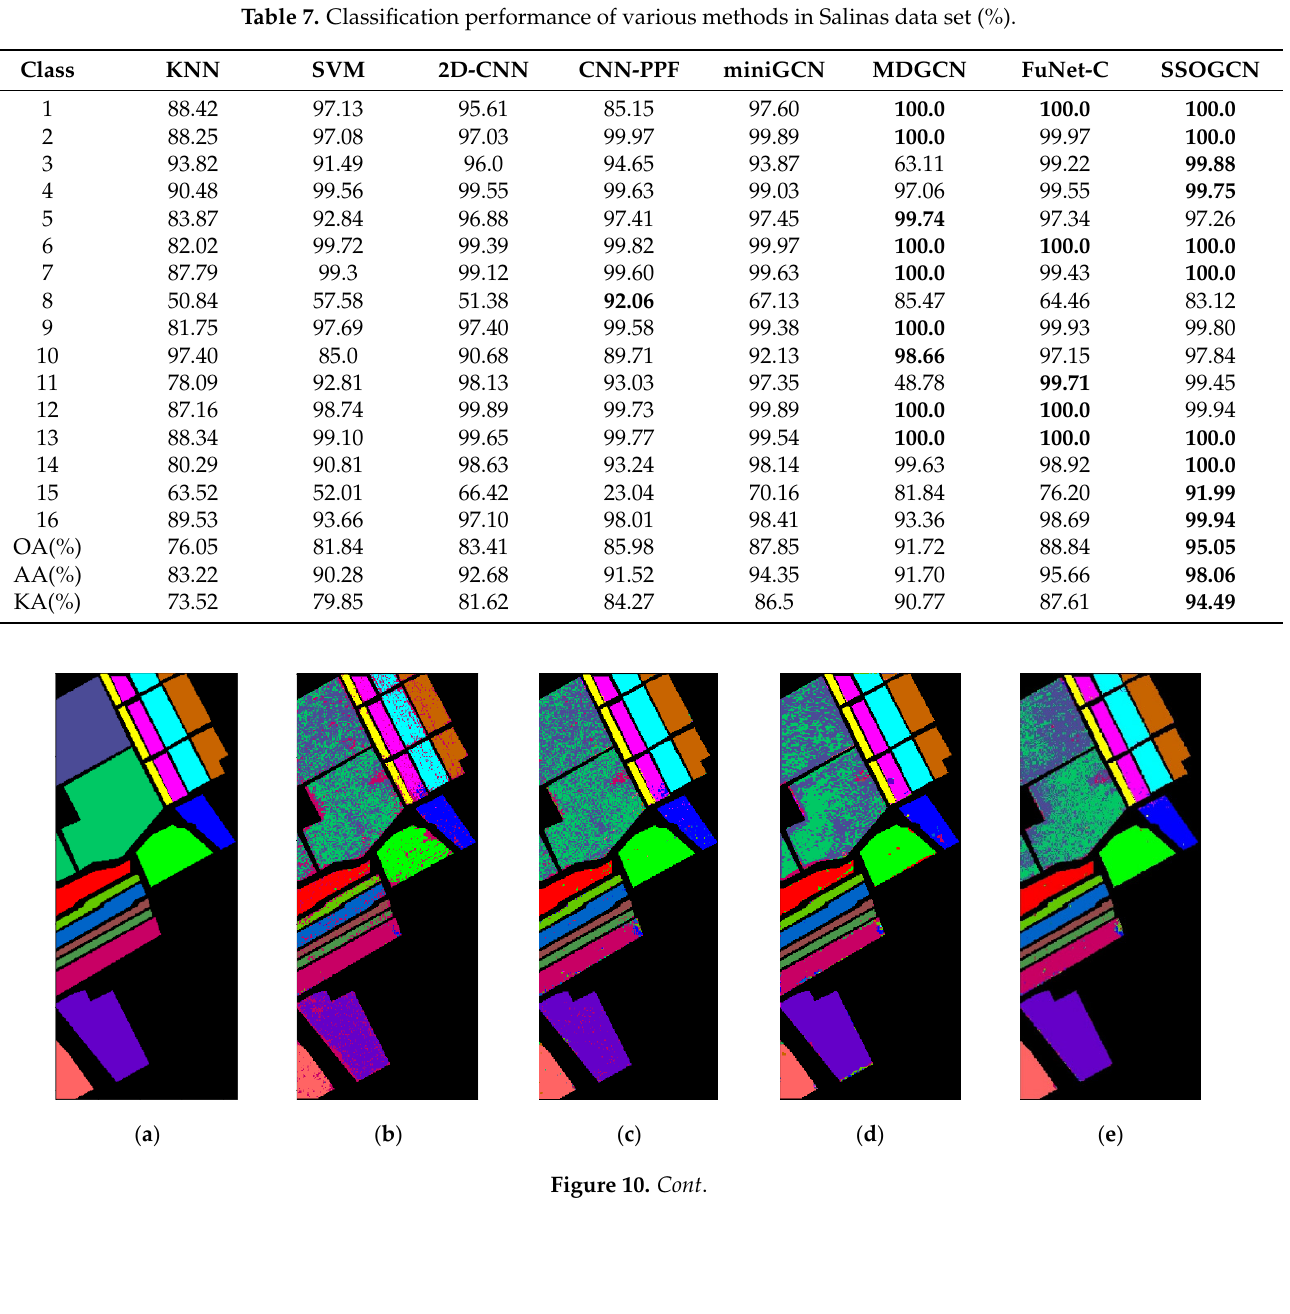
Table 7. Classification performance of various methods in Salinas data set